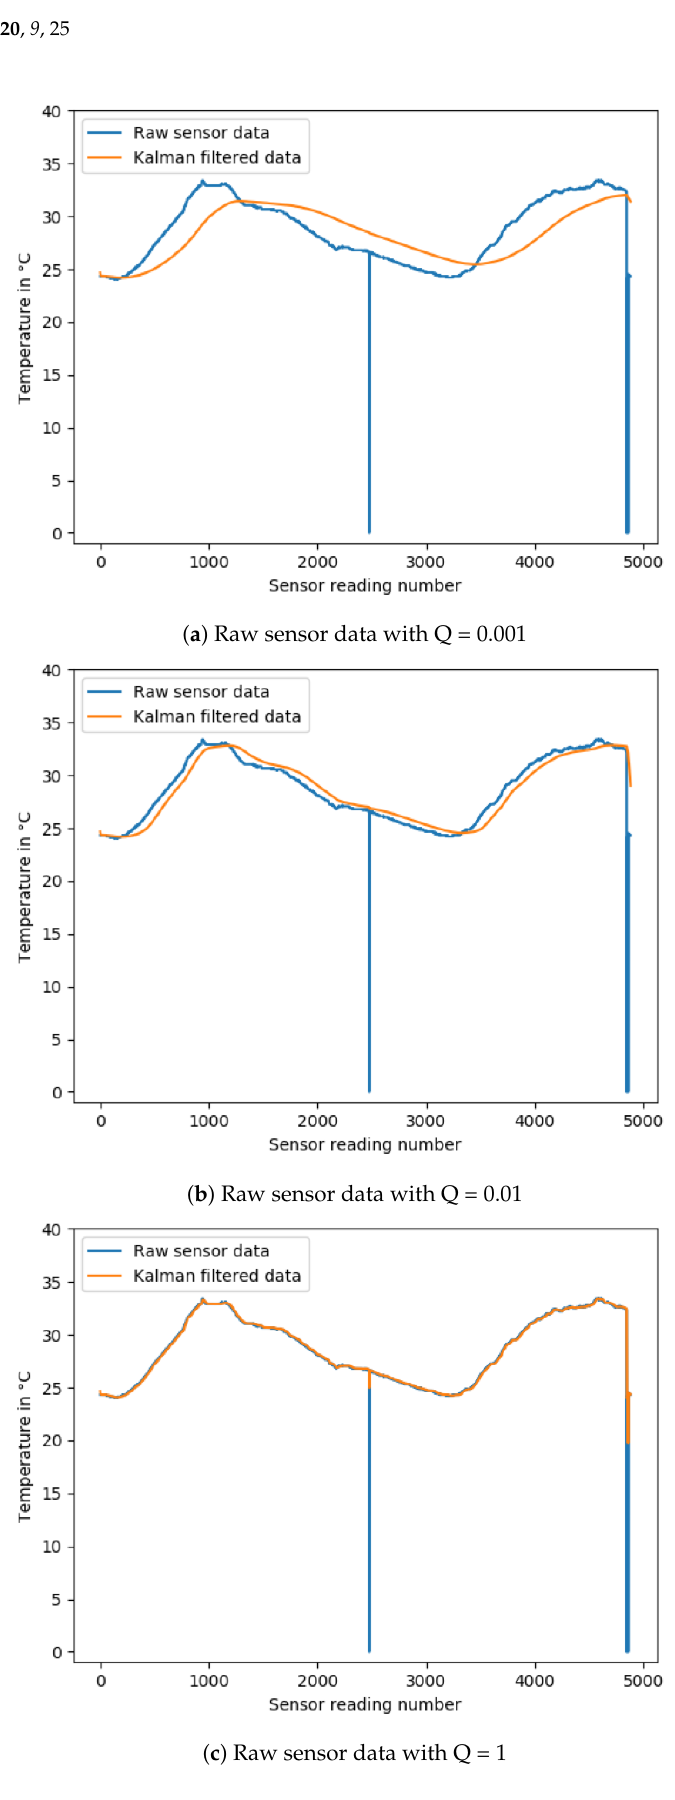
Figure 4. Scalar Kalman filter function with different Q values.